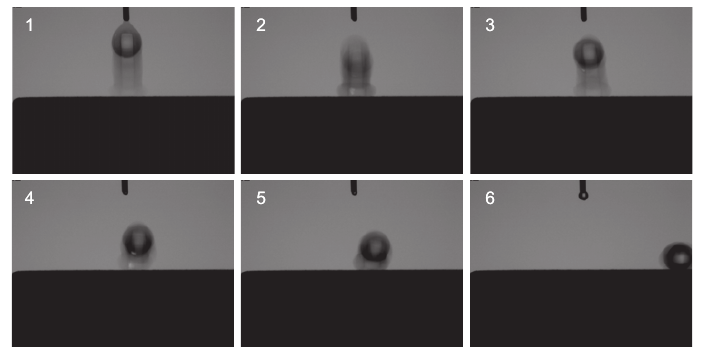
Figure 7 A water drop bouncing on a water-repellent surface. Because the force needed to start the drop moving is very small, the drop rolls off spontaneously. A sequence number is provided in the upper left corner of each photograph.